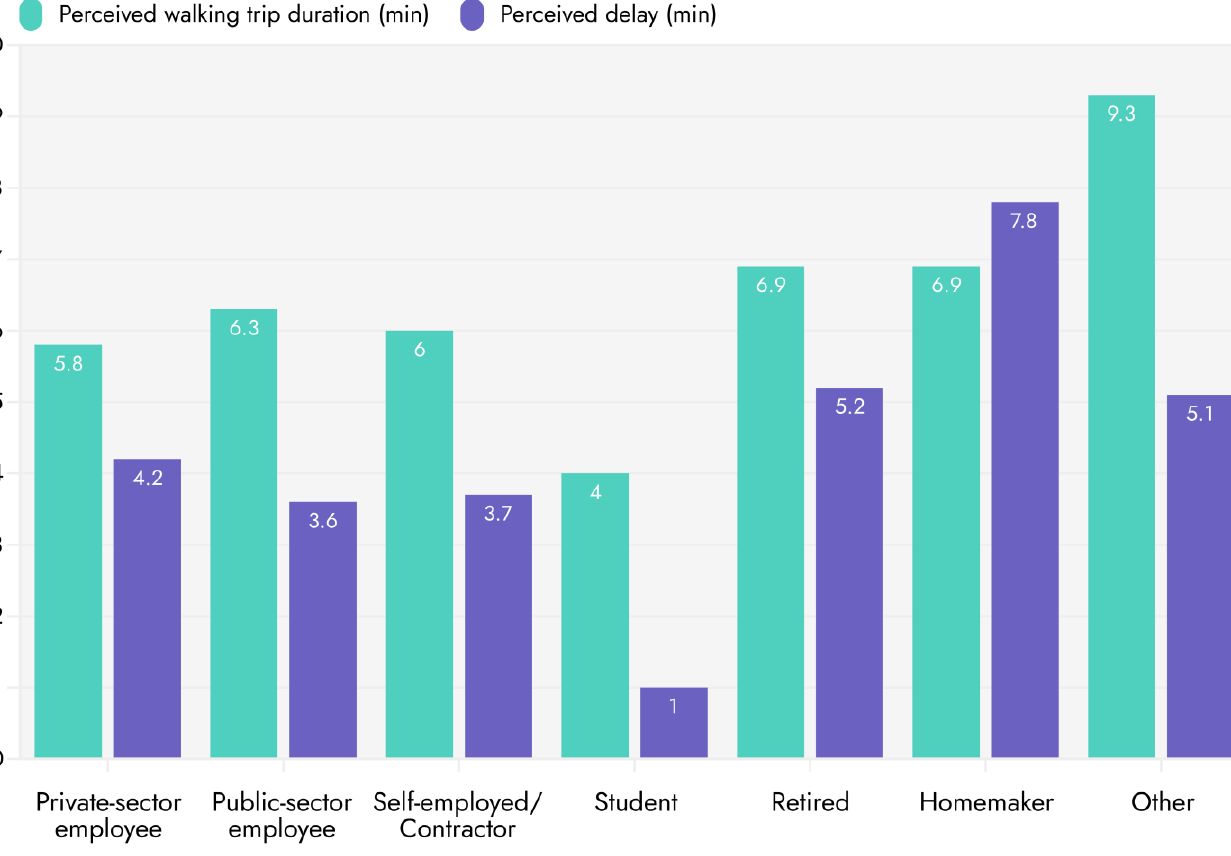
Figure 10. Violin plots of the delay perceived by men and women.